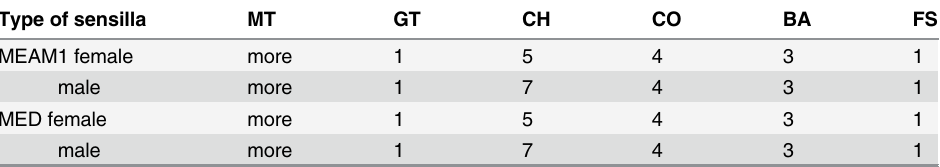
Abbreviation: MT: Microtrichia sensilla, GT: Grooved surface trichodea sensilla, CH: Chaetae sensilla, CO: Coeloconic sensilla, BA: Basiconic sensilla, FS: Finger-like